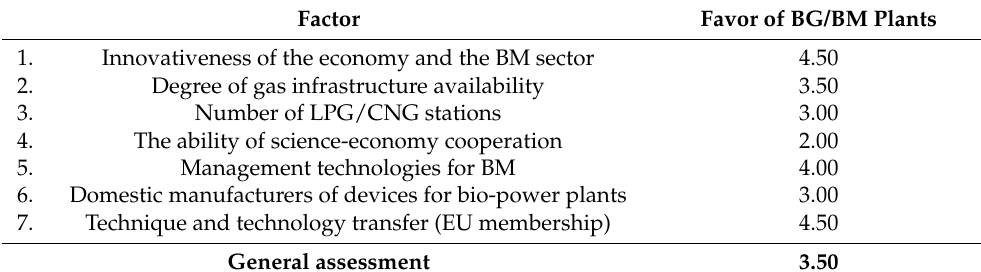
Table 7. Technological environment of BG/BM plants in Poland in the context of their develop- ment